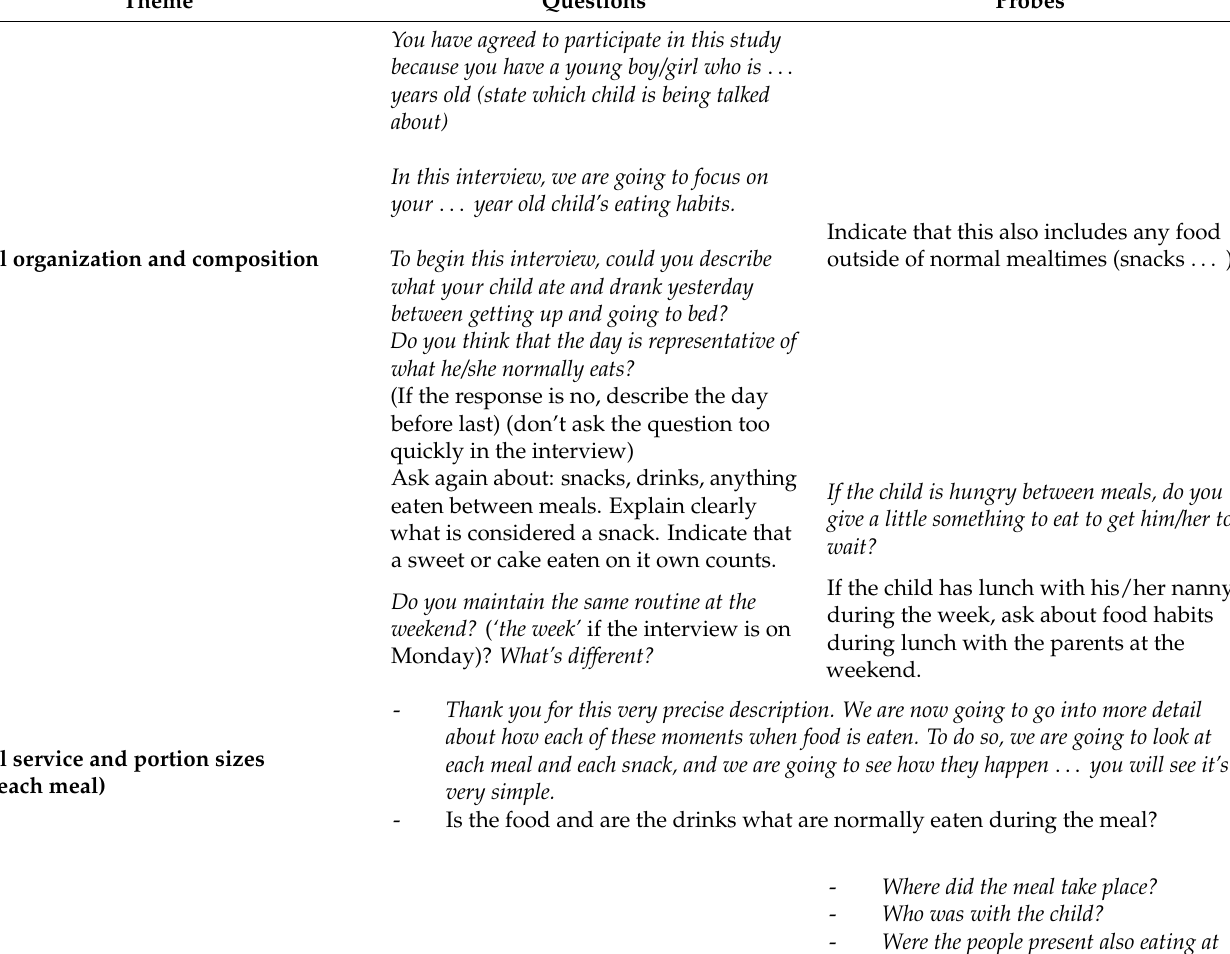
Table A1. Containing the themes, questions and probes addressed during the semi-structured interview. Theme